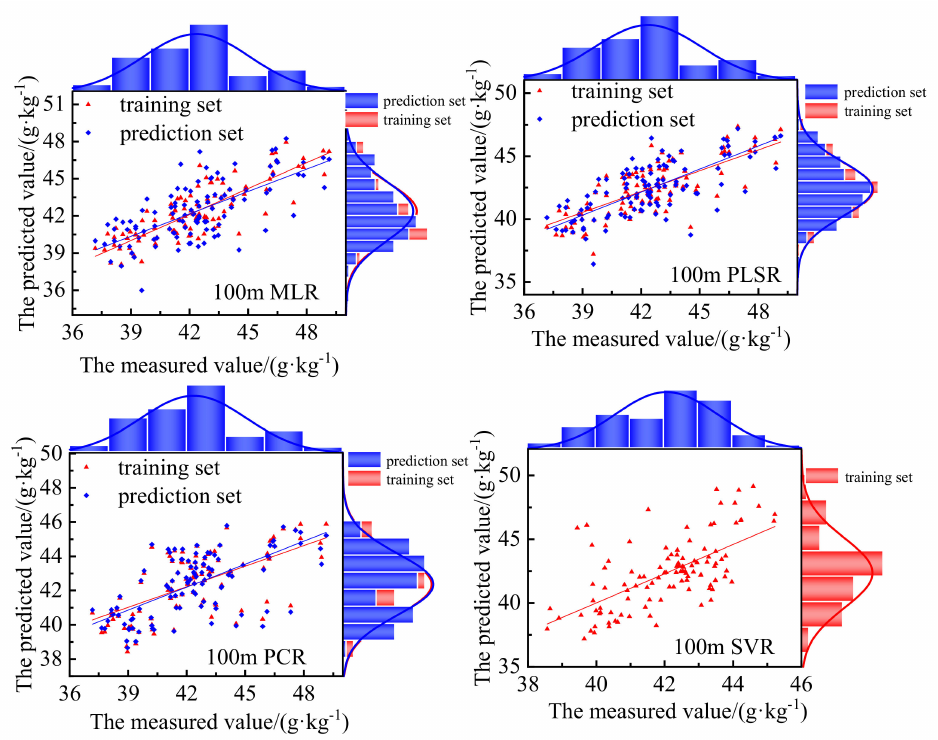
Figure 16. Scatterplots of the measured LNC vs. predicted LNC using multiple modeling methods (100